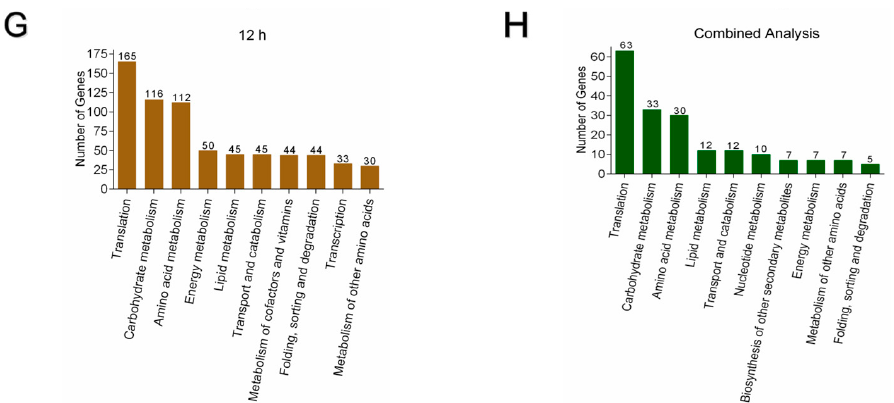
Figure 3. Summary of regulated genes. − (0.98 a w ) and + (0.90 a w ) represented two different a w ; the value of gene expression is significantly ( p < 0.05) differentially expressed (>two-fold) between the two groups. ( A ) Number of different expressed genes (DEGs) in each group; the red plot indicates up-regulated gene number and the green plot indicates down-regulated number. ( B ) Venn of DEGs in each group. ( C ) Top six of Gene Ontology (GO) categorization of three independent groups. The x -axis indicates the subcategories, and the y -axis indicates the number of genes in the same category. ( D ) Top six of GO categorization of combined analysis of three different groups. The red columns represent molecular function, green columns represent cellular component, blue columns represent biological process. Top 10 of KEGG pathways in 4 h ( E ), 8 h ( F ) and 12 h ( G ) group. The x -axis indicates the pathways, and the y -axis indicates the number of genes. ( H ) Top 10 of KEGG pathways of combined analysis of three